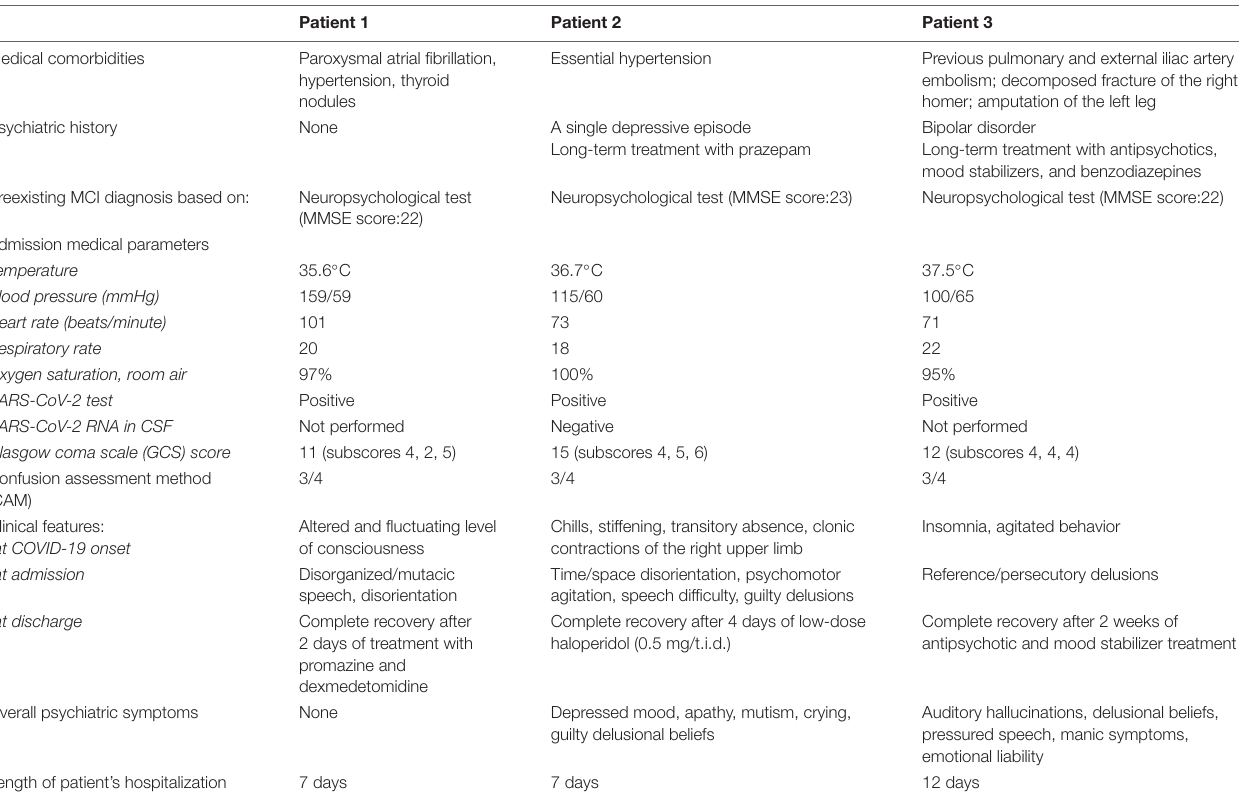
TABLE 1 | Medical and psychiatric characteristics of the three patients included in the